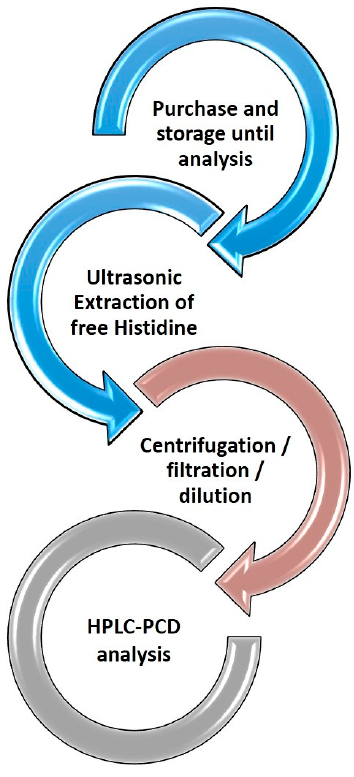
Figure 2. Representative workflow of the HPLC-PCD method for the determination of free histidine in hair care products.